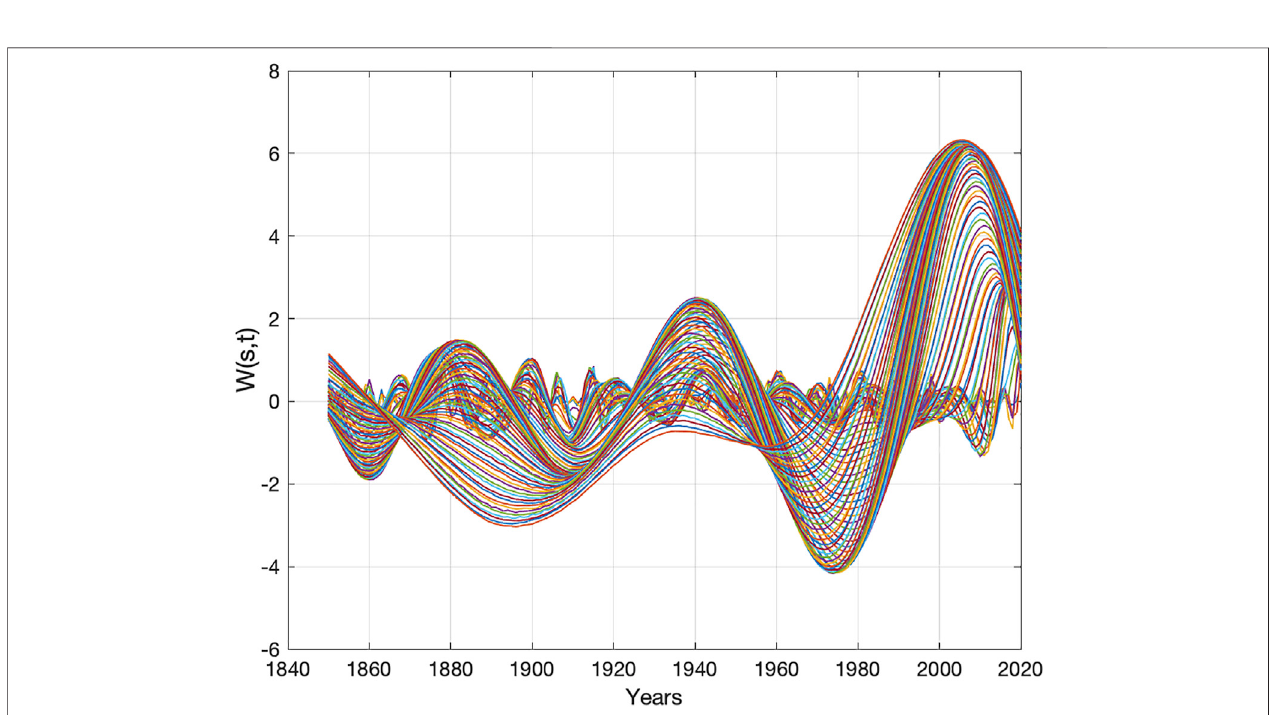
FIGURE 3 | Global sea surface temperature (HadSST3) wavelet spectrum, Wgst (s, t), for s = (1 ... 85) and t = (1850 ... 2020) (yr.).